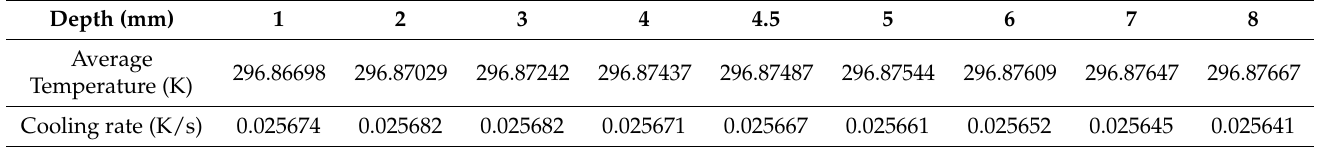
Figure 5. Temperature graph of the feature point during the cooling process. Table 2. Average temperature and cooling rate of the selected point from each